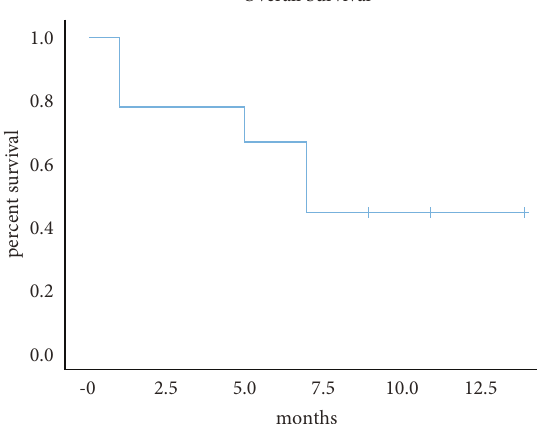
Figure 1: Kaplan–Meier estimates for the treated population.